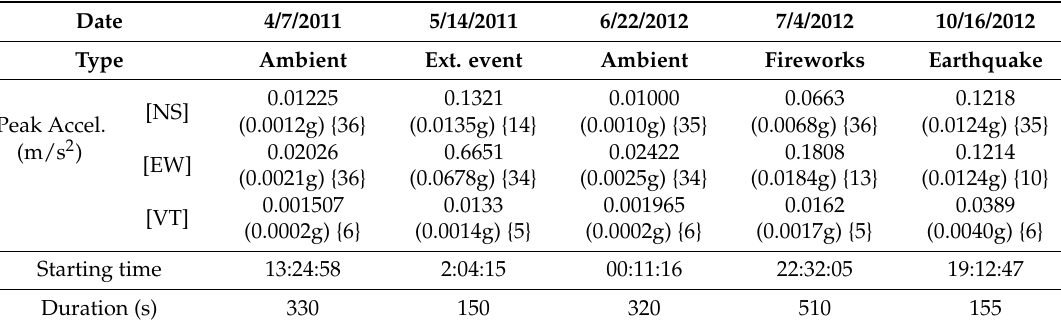
Table 1. Summary of collected measurement data